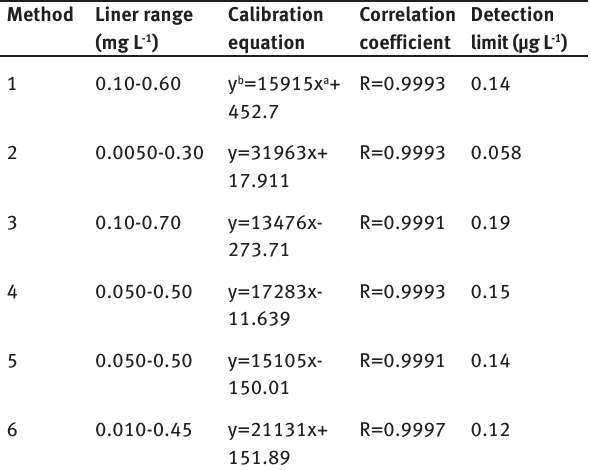
Table 1: Performance date for determination of ENR, LMF and NOR in aqueous